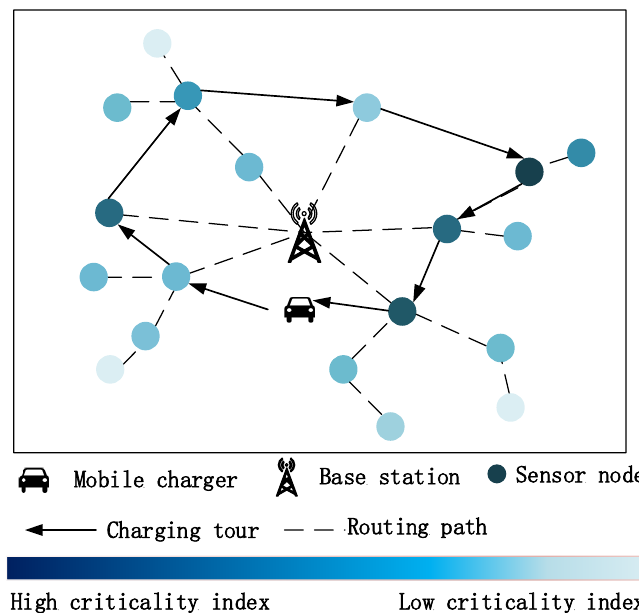
Figure 2. Illustration of the network architecture.